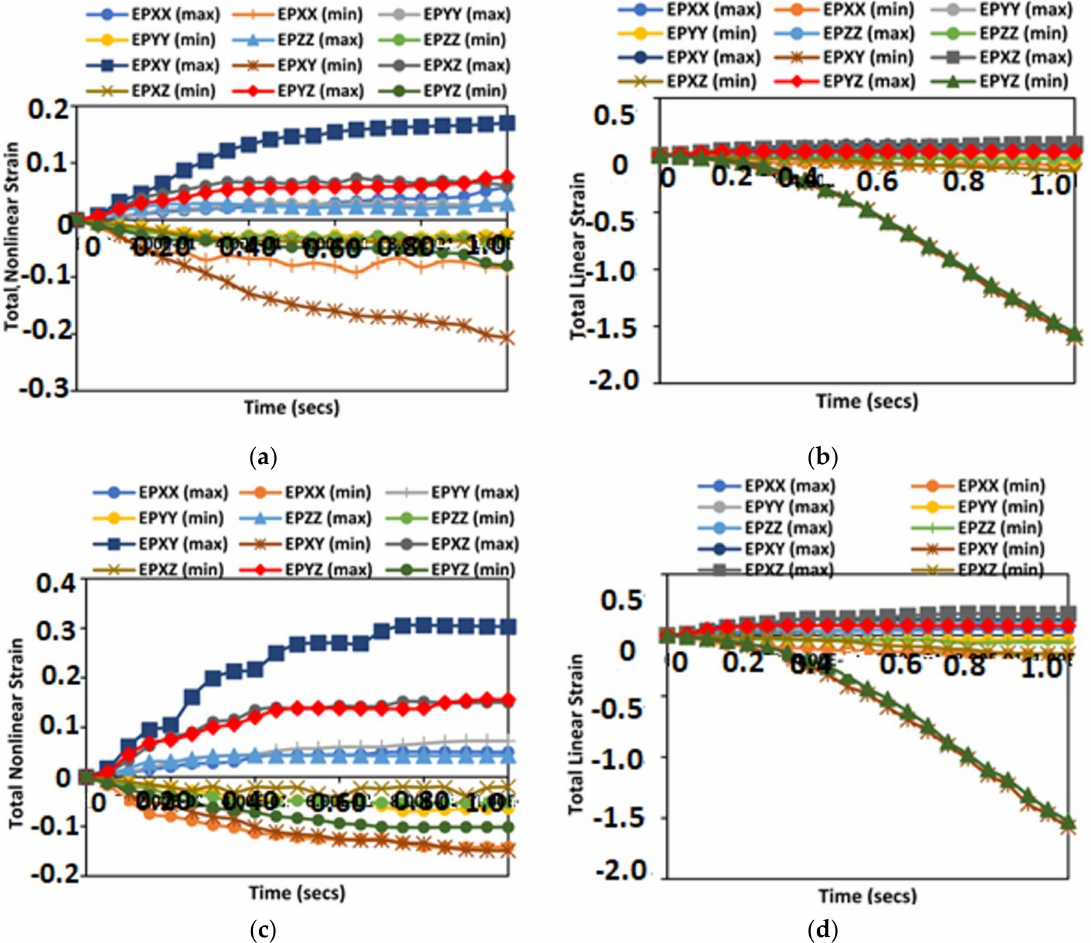
Figure 11. The total strain profiles for the reeling hose Nylon PA66GF composite model, showing ( a ) total nonlinear strain of nylon PA66GF linear elastic model, ( b ) total linear strain of nylon PA66GF linear elastic model, ( c ) total nonlinear strain of nylon PA66GF elastoplastic model, ( d ) total linear strain of nylon PA66GF elastoplastic